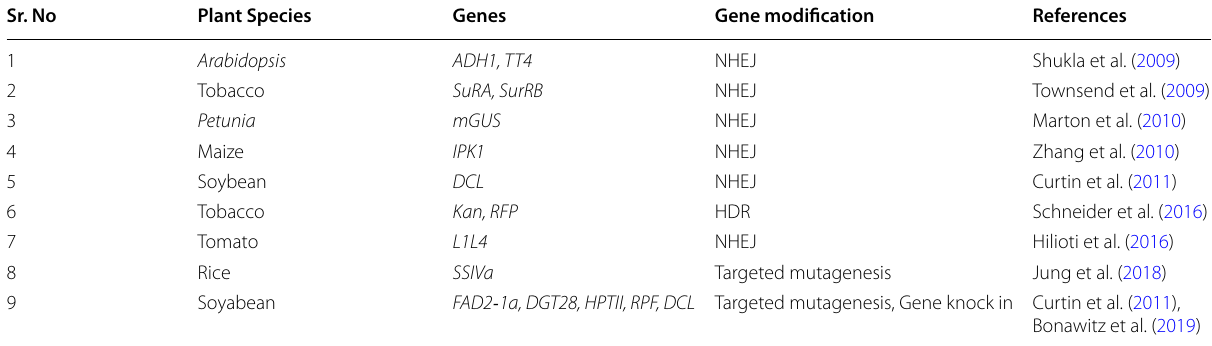
Table 2 ZFN-mediated genome modifications in plants Sr.